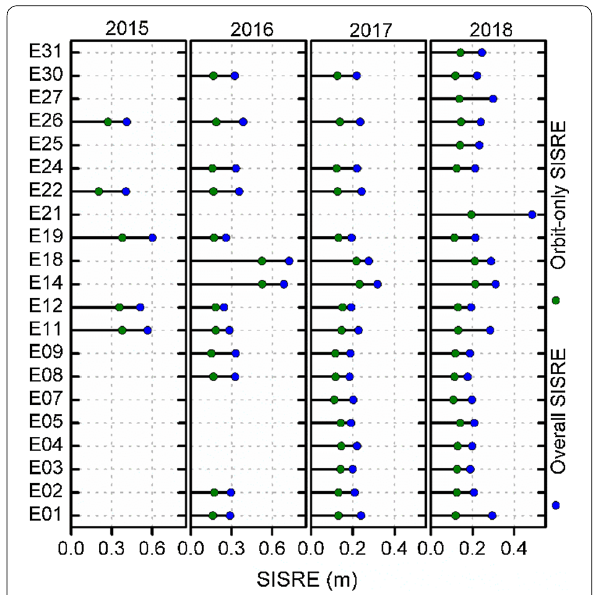
Fig. 10 Annual mean RMS of orbit-only ( green dots ) and global average ( blue dots ) SISREs for each Galileo satellite from